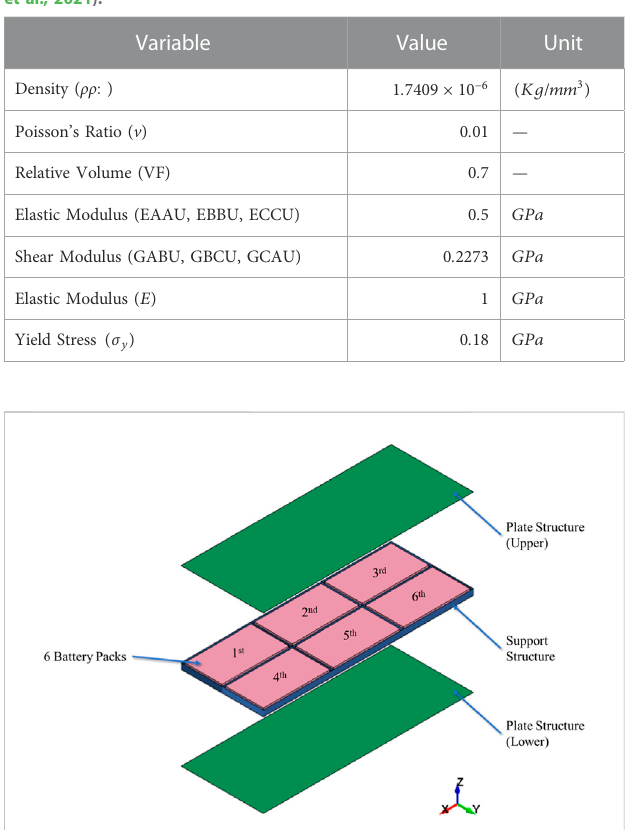
FIGURE 7 Exploded view of the battery housing system, consisting of 6 battery packs (pink), the support structure (blue), and the plate structure